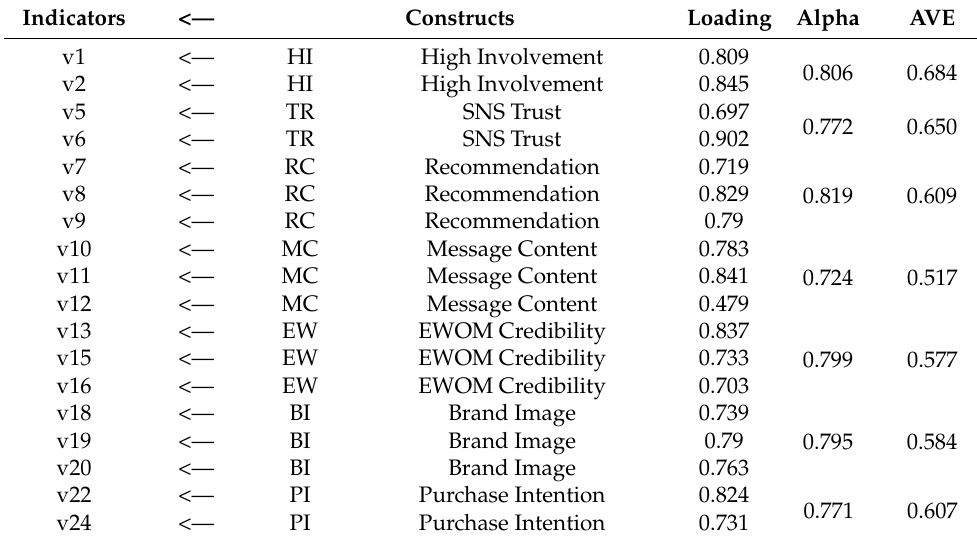
Table 2. Measurement model—indicator loadings, reliability and